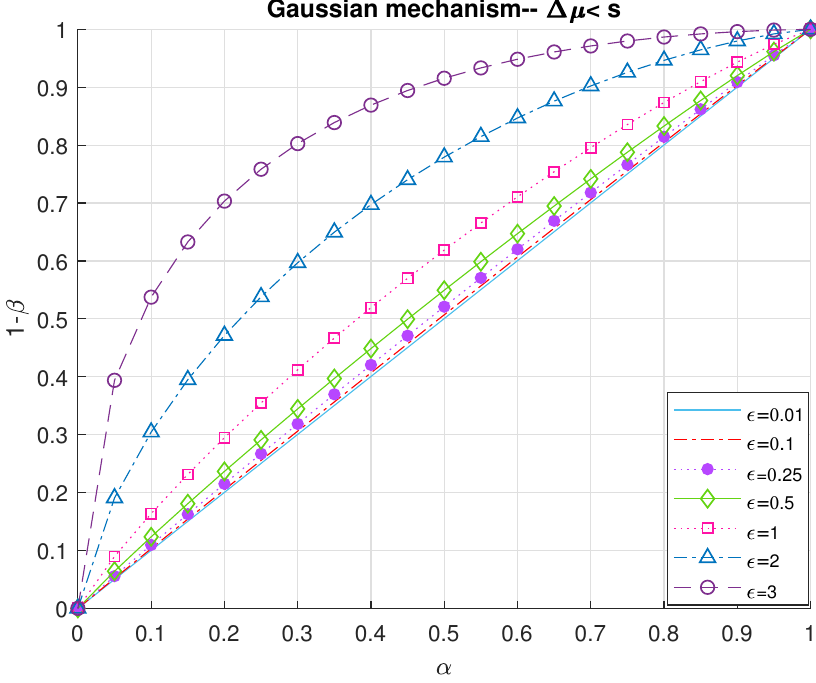
Figure 7. Equations (62) and (63) for various values of (cid:101) , ∆ µ < s and δ = (cid:101)